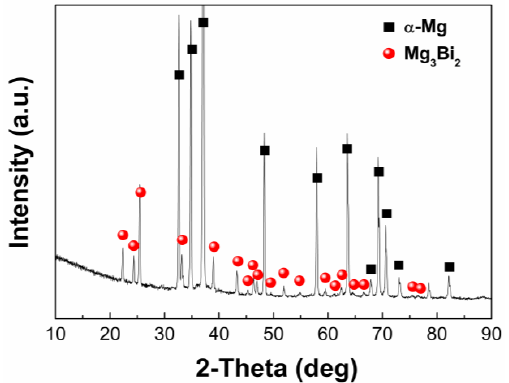
Figure 2. X-ray diffraction spectra of as-homogenized BAZ631 alloy at 450 °C for 5 h. Figure 3 indicates OM and SEM images taken of longitudinal sections of the as-ex- truded BAZ631 alloy. The as-extruded BAZ631 sample exhibits a homogeneous micro- structure which is almost fully dynamic recrystallized (DRXed), as presented in Figure 3a,b. Compared with the homogenized sample, the DRXed microstructure of the extruded sample has been greatly refined with an AGS of 2.9 ± 0.4 μm, clearly presented in Figure 3c,d. Moreover, the micron Mg 3 Bi 2 strips and broken particles (Figure 3b,c) distributed along the ED, which is original from insoluble Mg 3 Bi 2 phase particles in homogenized microstructure (Figure 1). In particular, as shown in Figure 3d, high magnification SEM image of the as-extruded BAZ631 specimen suggests numerous fine intermetallic parti- cles, which were not detected in the as-homogenized sample, demonstrating that dynamic precipitation happened during extrusion. Figure 3. OM ( a , b ) and SEM ( c , d ) micrographs of as-extruded BAZ631 alloy; ED: extrusion direction. In order to elucidate the precipitation behavior of BAZ631 alloy during extrusion, TEM characterization was conducted, and the corresponding results are presented in Fig- ure 4. Both micro-scale second phase and ultra-fine precipitates dispersed in the fine DRXed matrix, which well agreed with the OM and SEM observations. The most distinc- tive feature of the TEM microstructures is that abundant nano-scale globular particles